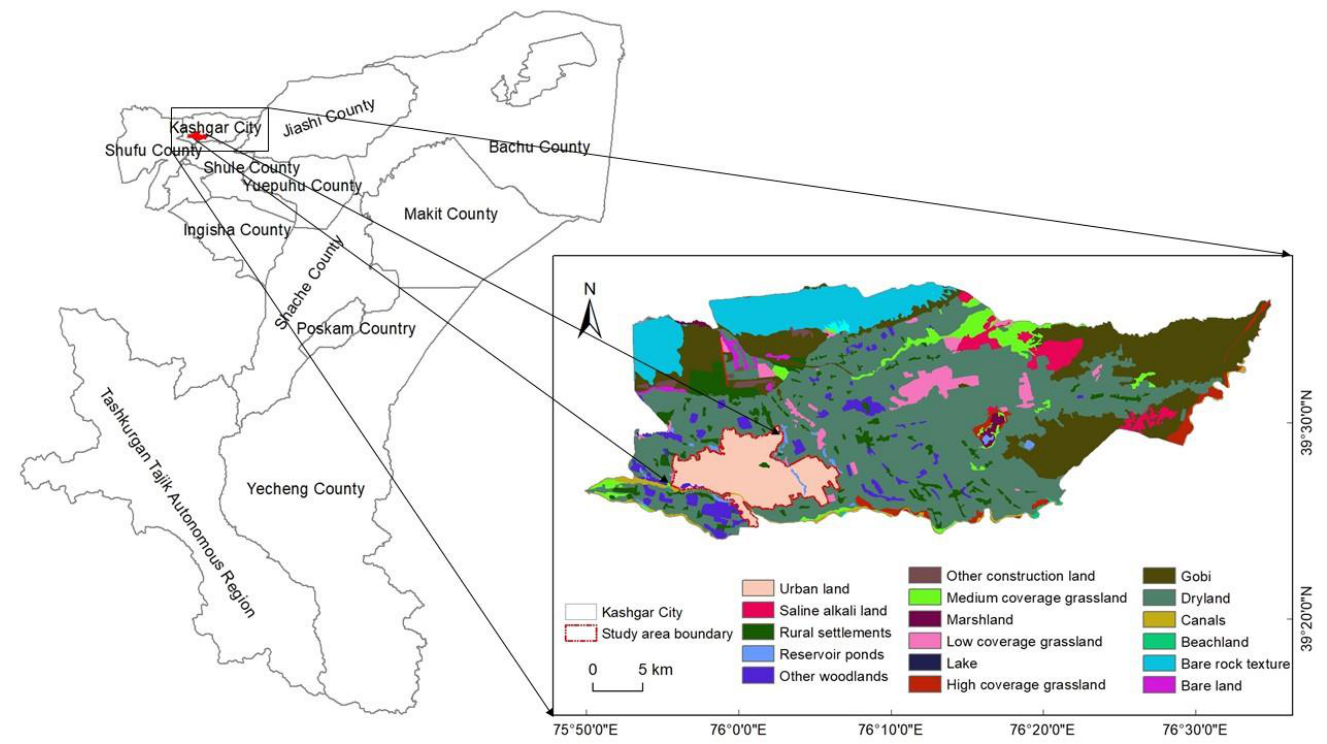
Figure 1. Study area